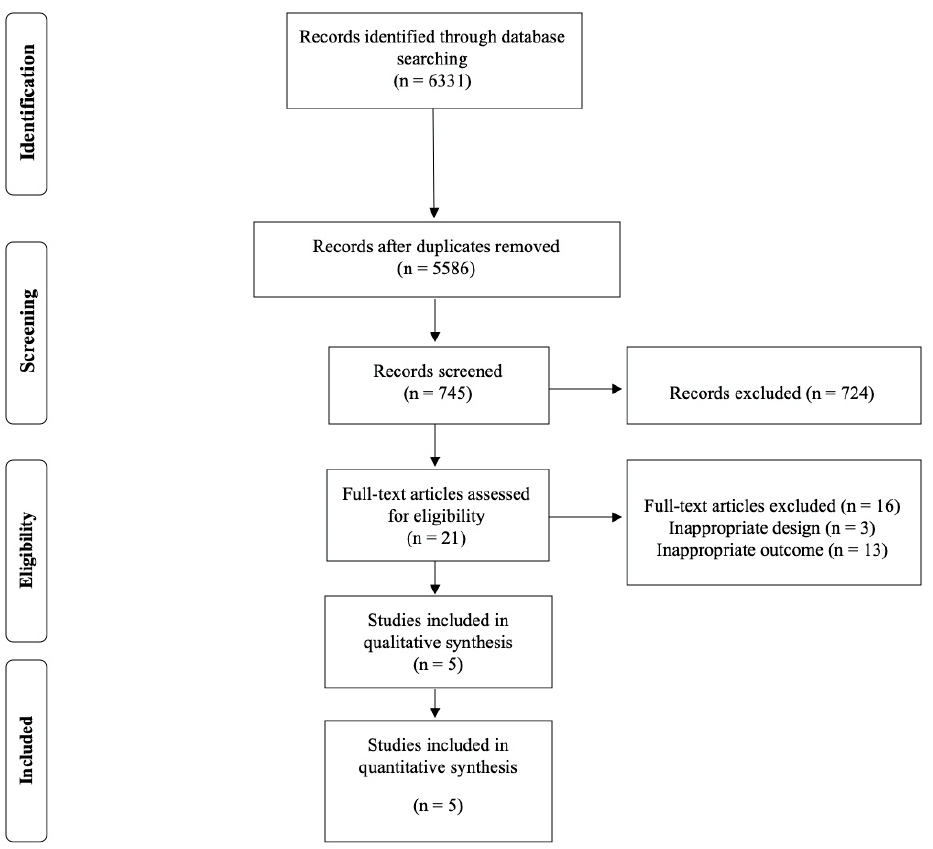
Figure 1. Flowchart of literature search.